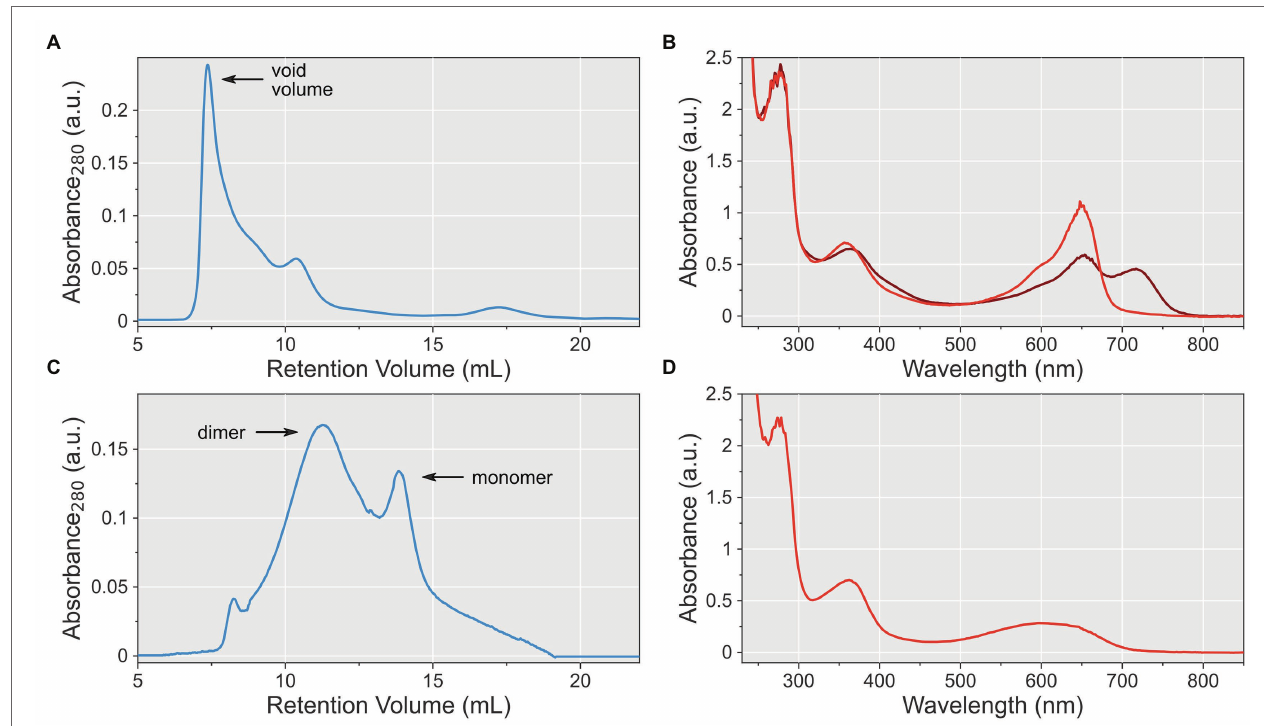
FIGURE 3 | Optimization of solution conditions for purification of At phyA at full length. (A) Size-exclusion chromatography (SEC) of At phyA at pH 8.0. The void volume of the column is indicated. (B) UV/vis absorbance spectra of At phyA at pH 9.3 after illumination with 650 nm (brown) and 720 nm (red), respectively. (C) SEC of At phyA at pH 9.3 reveals a mixture of apparent dimeric and monomeric species. (D) UV/vis absorbance spectrum of At phyA at pH